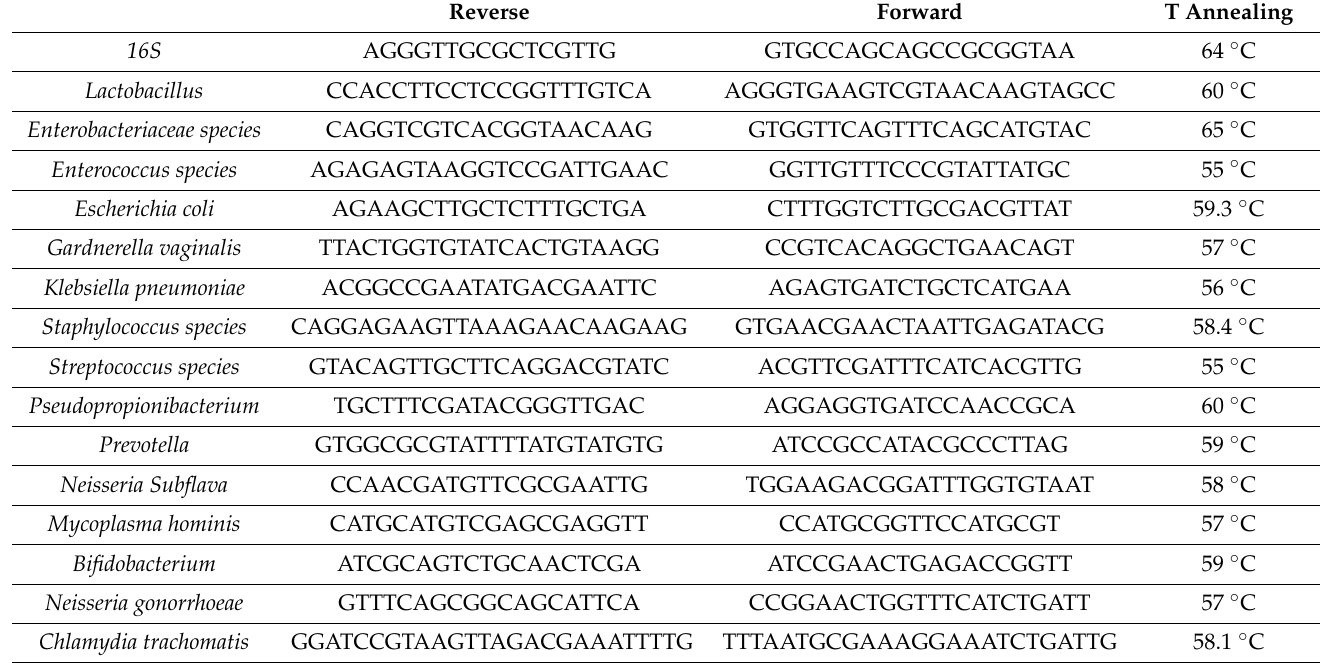
Table 1. Nucleotide sequences and annealing temperature of the primers utilized in PCR